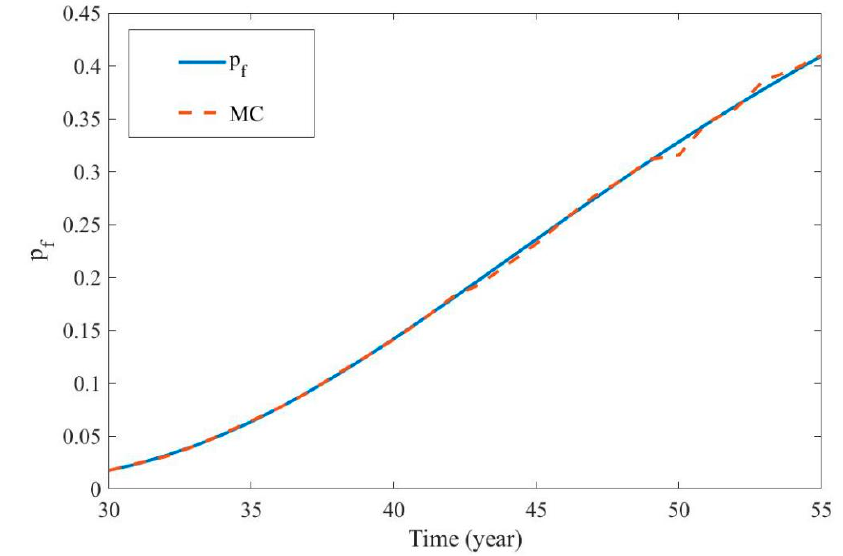
Figure 15. Time-varying failure probability and MC simulation ( 2 N/mm 18.0=